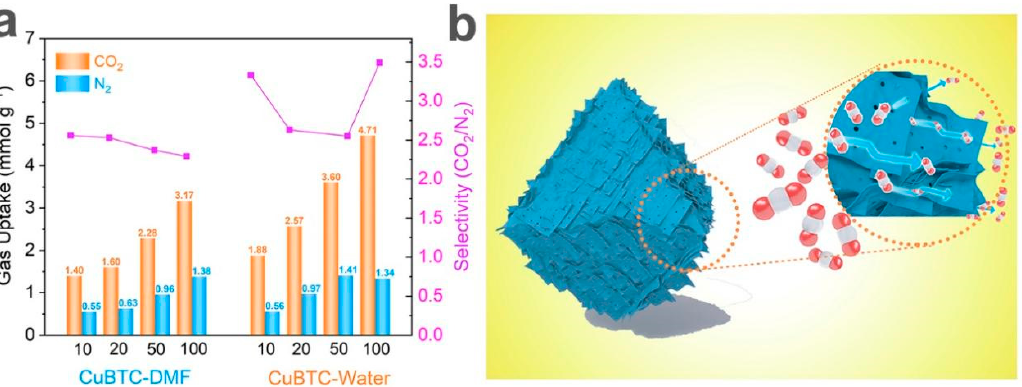
Figure 5. ( a ) Gas uptake amount and selectivity of CuBTC-DMF and CuBTC-Water. ( b ) Schematic illustration for CO 2 separation under dynamic conditions through hierarchically porous CuBTC-Water. The circle area indicates the schematically enlarged MOF crystal for CO 2 /N 2 separation.